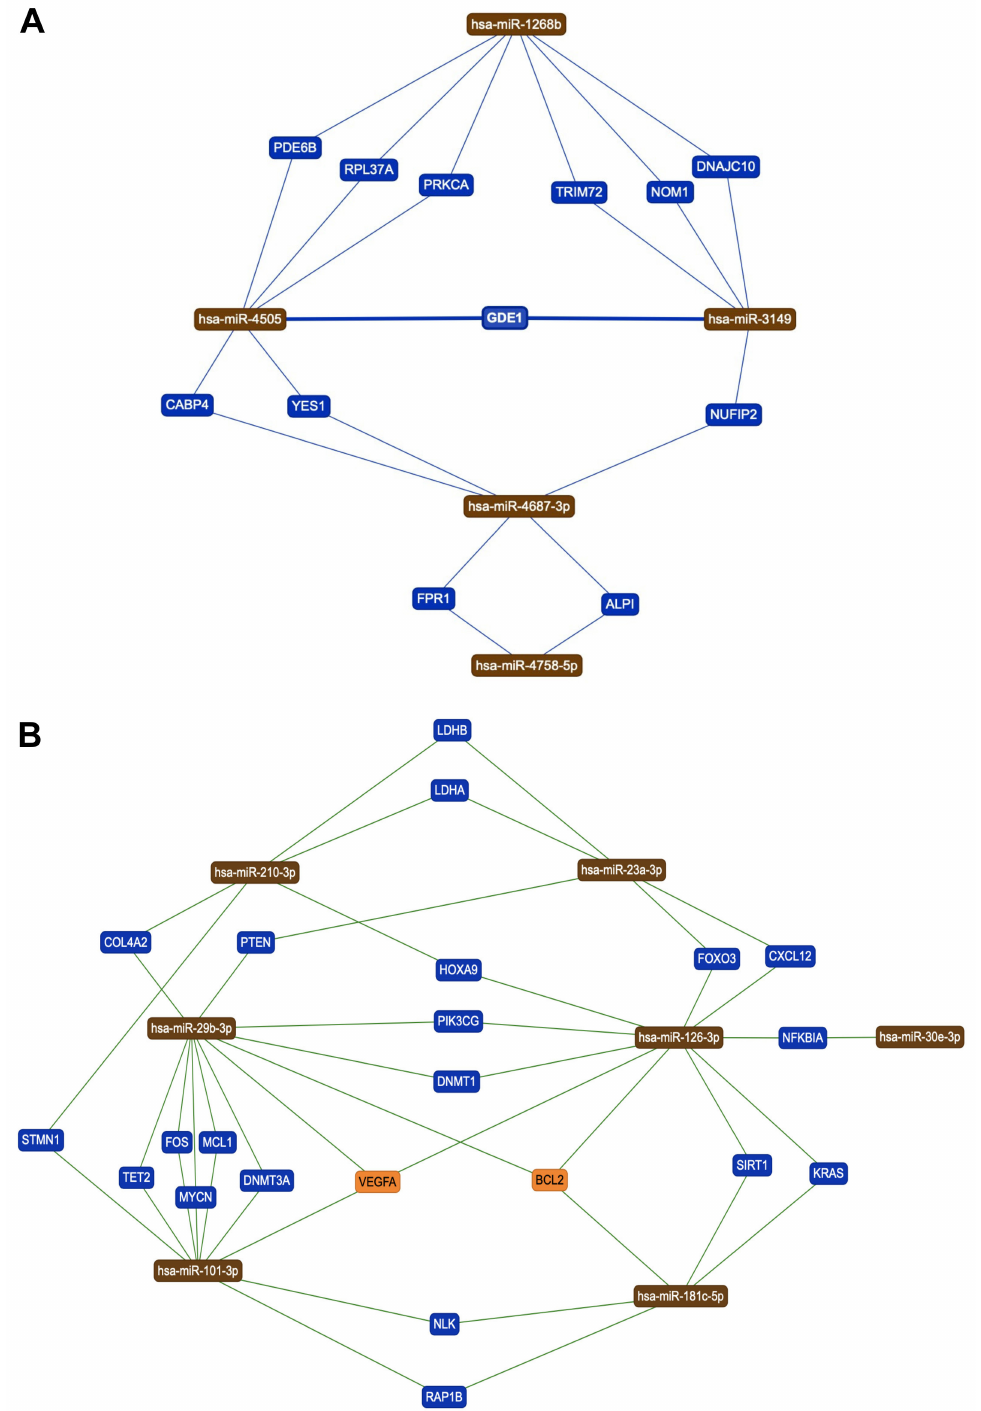
Figure 3. ( A ) miRNA–mRNA interaction network for the five miRNAs up-regulated after pesticide exposure; ( B ) miRNA– mRNA interaction network for the 15 miRNAs down-regulated miRNAs after pesticide